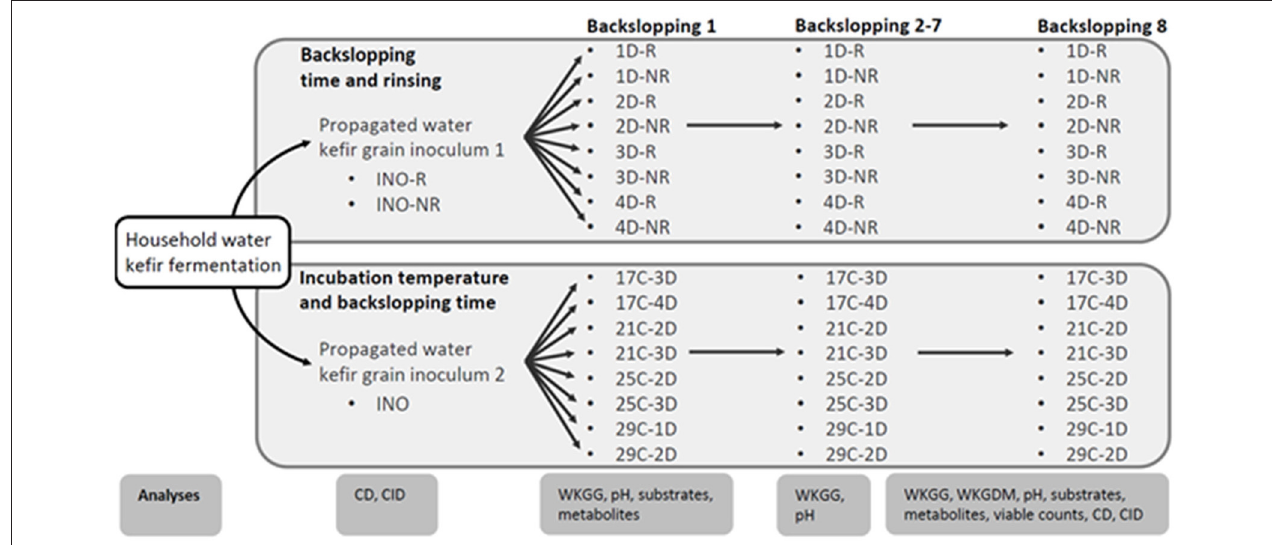
FIGURE 1 | Schematic overview of the household water kefir fermentation processes, the water kefir grain inoculum 1 (INO-R and INO-NR) and 2 (INO) obtained through a series of prefermentations, the eight series of water kefir fermentations differing in backslopping time and rinsing or not rinsing off the water kefir grains during each backslopping step, and the eight series of water kefir fermentations differing in incubation temperature and backslopping time, as well as the different analyses performed throughout the experimental process. The varied process parameters were the backslapping time D (1, 2, 3, or 4 days), the incubation temperature C (17, 21, 25, or 29 ◦ C), and the rinsing of the water kefir grains during each backsloppings step [rinsed (R) or non-rinsed (NR)]. Analyses included culture-dependent (CD) and culture-independent (CID) microbial species diversity, substrate consumption (substrates), metabolite production (metabolites), water kefir grain growth (WKGG), water kefir grain dry mass (WKGDM), pH, and/or viable